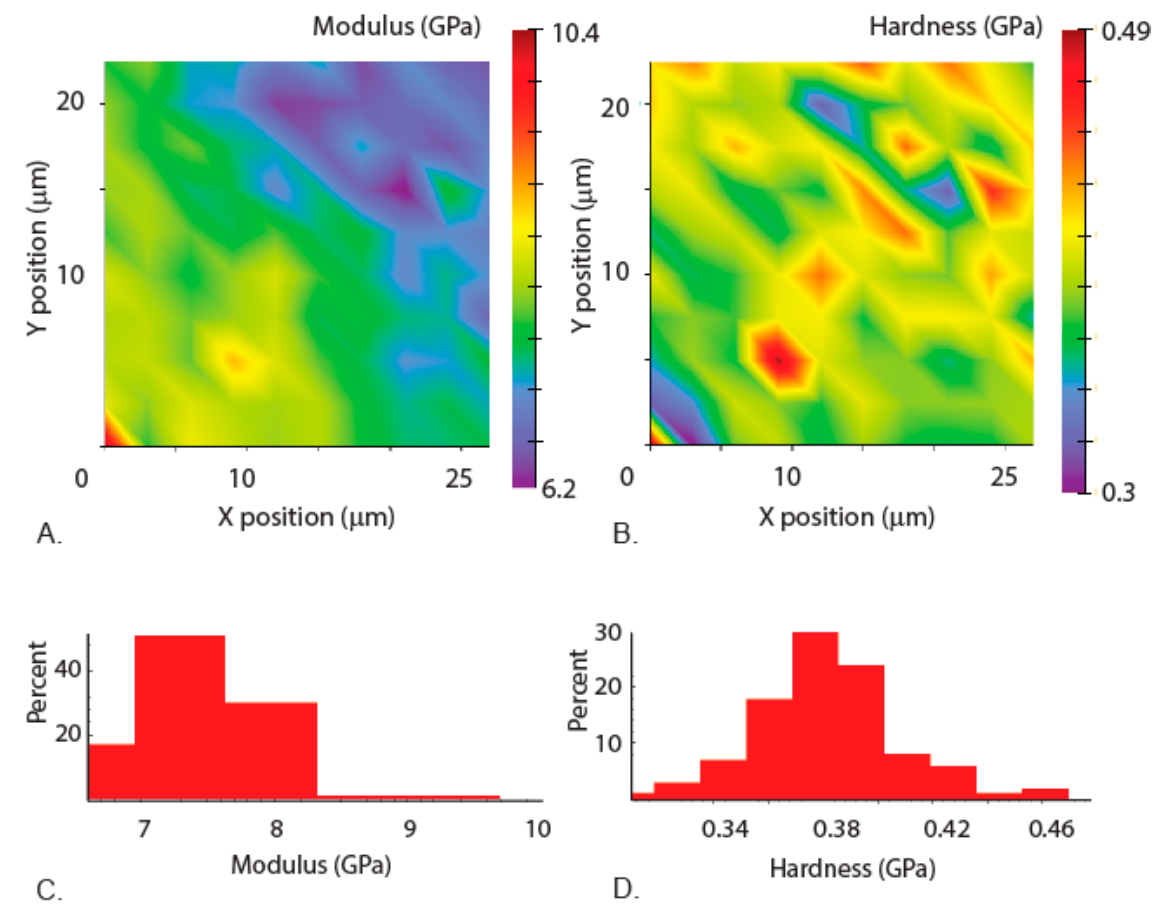
Figure 7. Measurements from the region away from the tip (as shown in Figure 6C). ( A ) Elastic modulus mapping across the layers. ( B ) Hardness mapping across the layers. ( C ) Corresponding elastic modulus values sorted into bins to show the variation and percentage. ( D ) Corresponding hardness values sorted into bins to show the variation and percentages.